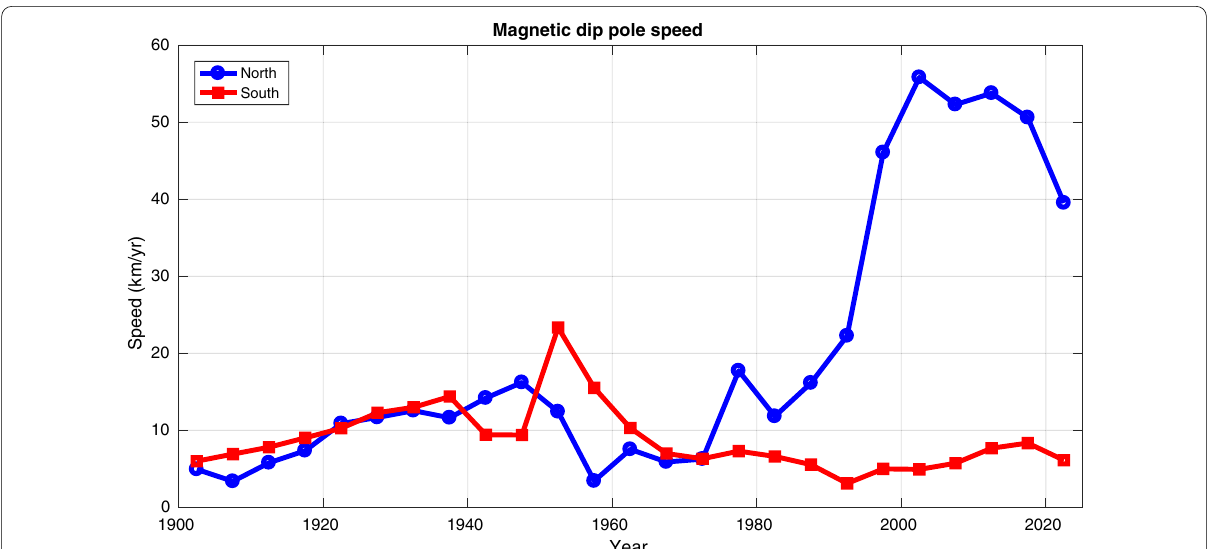
Fig. 4 Average speed of the magnetic dip poles over each 5‑year epoch, plotted at the midpoint between epochs (i.e., the speed over 2015–2020 is shown at 2017.5). The value for 2020–2025 is a forecast